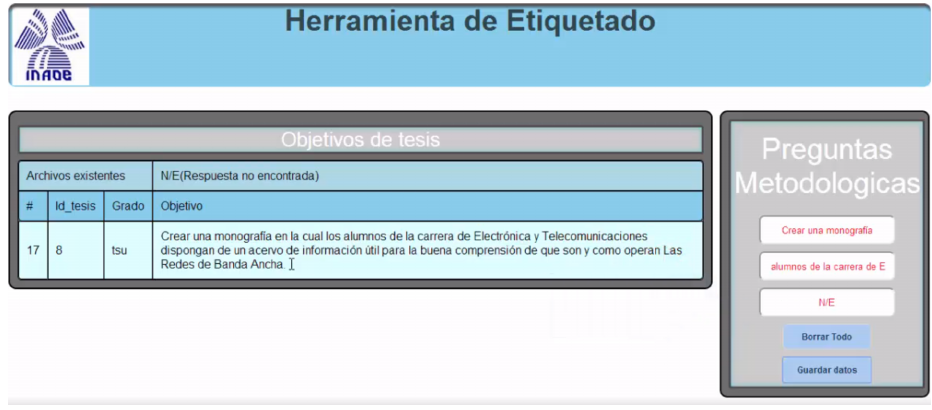
Figure 1. Objective Tagger Tool.